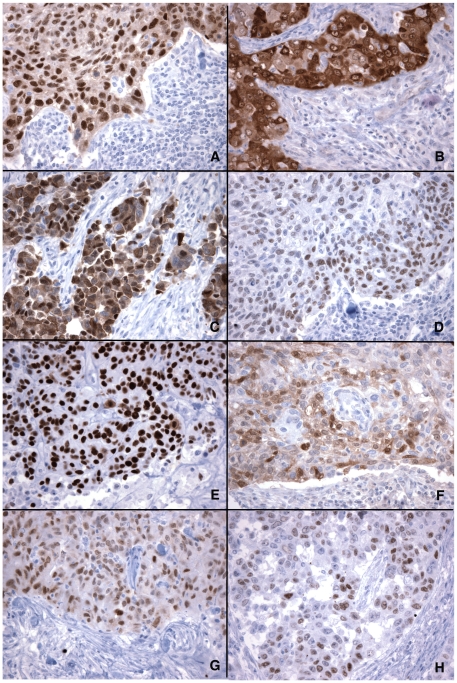
Immunohistochemical analysis of CT antigen expression in breast cancer.Eight CT antigens were analyzed– MAGEA (A), NY-ESO-1 (B), CT7 (C), CT10 (D), CT45 (E), GAGE (F), NXF2 (G) and SAGE1 (H). Of these, MAGEA, NY-ESO-1, CT7 and GAGE showed mixed nuclear and cytoplasmic staining, whereas CT10, CT45, NXF2 and SAGE1 were purely or predominantly nuclear proteins. (Magnifications: 400X).